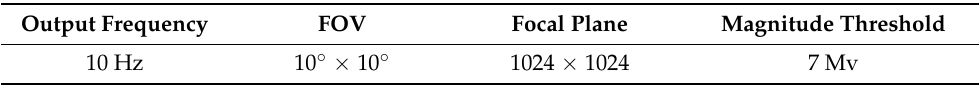
Table 2. Specifications of the star sensor.